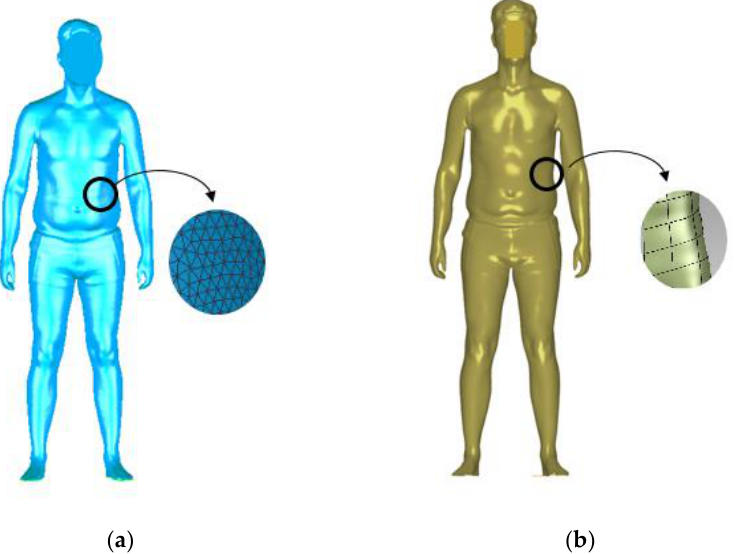
Figure 1. ( a ) Polygon model and ( b ) NURBS (Non-uniform rational B-splines) model of a test person.